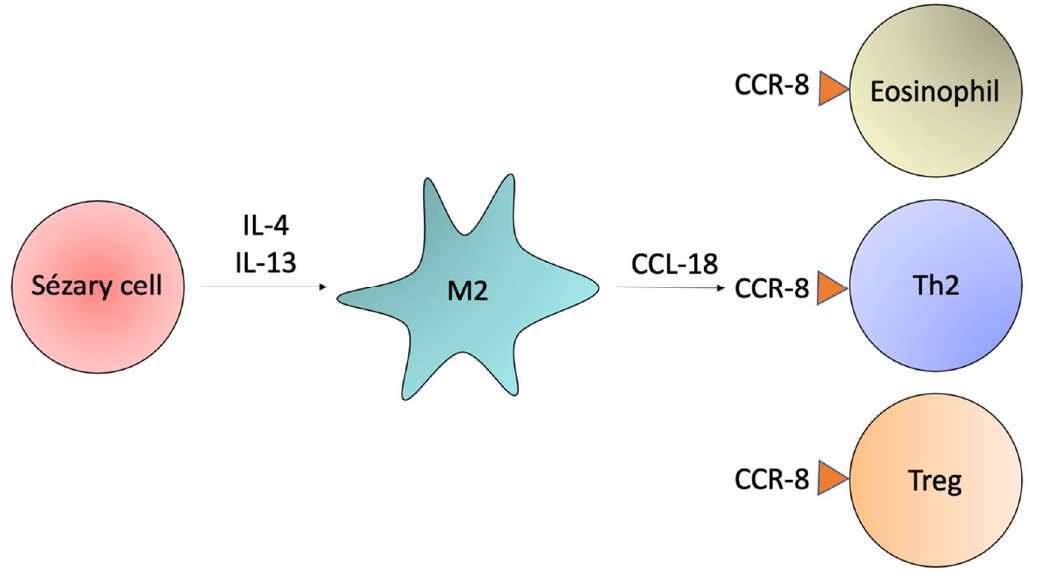
Figure 5. M2 macrophages. Sézary cells produce the Th2 cytokines IL-4 and IL-13. These cytokines stimulate M2 macrophages to produce CCL18, a chemokine that attracts CCR8+ cells to the tumor microenvironment. The CCR8 is expressed by eosinophils, Th2 cells, and Treg. The phagocytic activity of macrophages is also impaired in SS. The Th2 microenvi- Sézary cells. The CD47 binds to its receptor, the signal regulatory protein α (SIRPα), on